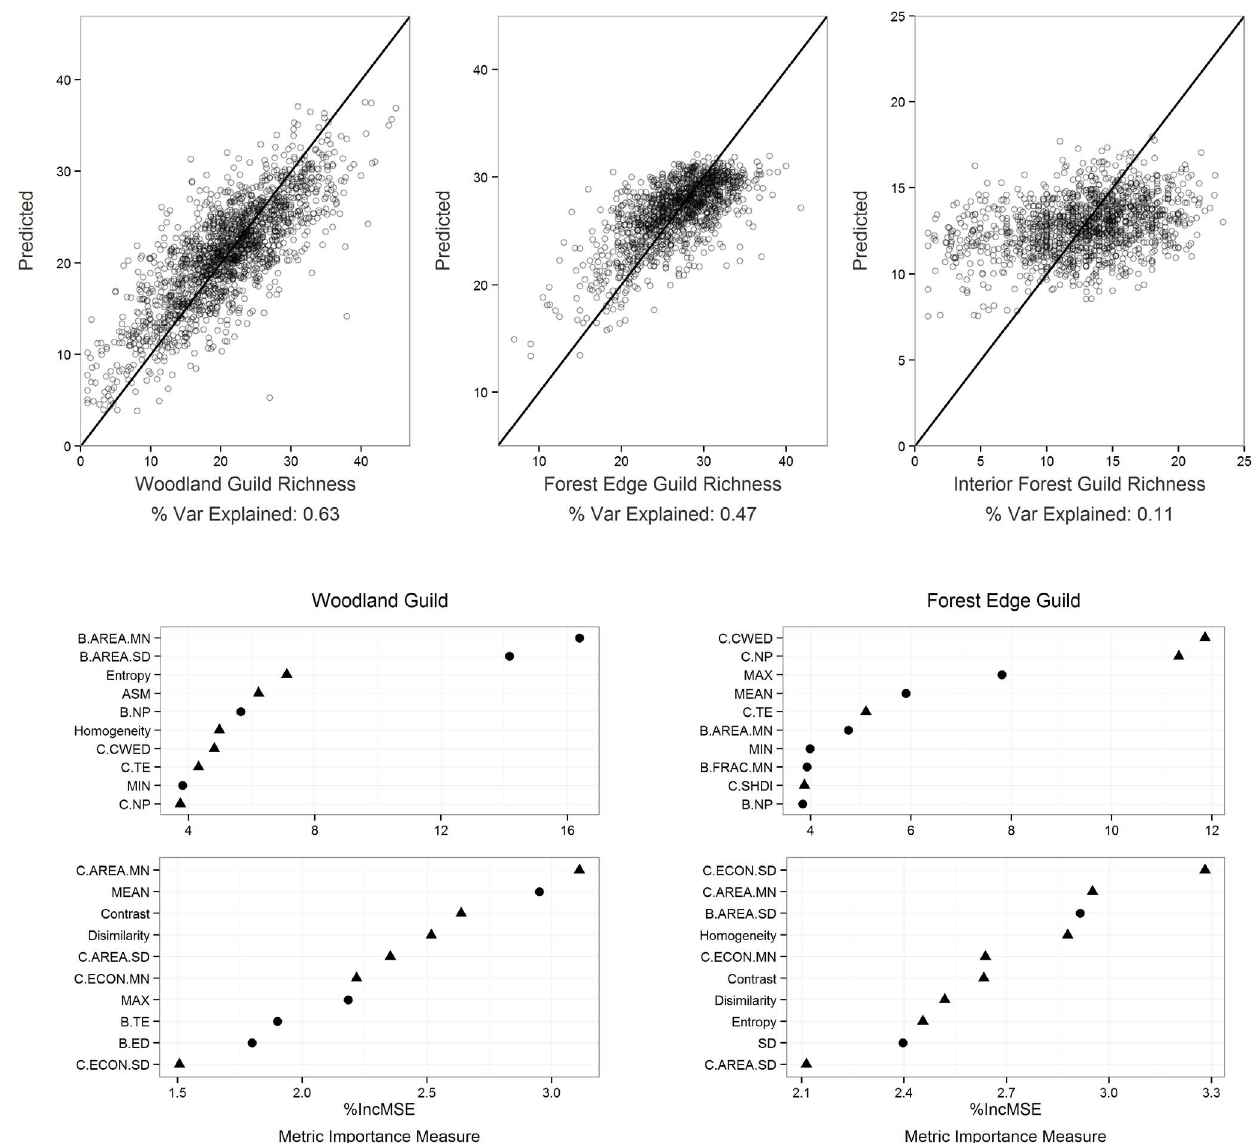
Figure 5. Random Forest model results. (Top row): Modeled vs. actual species richness for three guilds using all-inclusive random forest models. (Below the scatter plots): variable importance plots show the percent increase in mean square error (%IncMSE) of the top 20 most influential metrics in the woodland guild richness model and the forest edge guild richness model (note different scales on X-axes). The metrics characterizing vegetation height heterogeneity are plotted with triangles and the rest of the metrics are circles. Table S2 Species list and guild classification. Table S3 Metric descriptions. Table S4 Metrics correlation with species richness. Table S5 Model performances for different multivari- Table S1 Ecological provinces involved and the sub- region assignment.